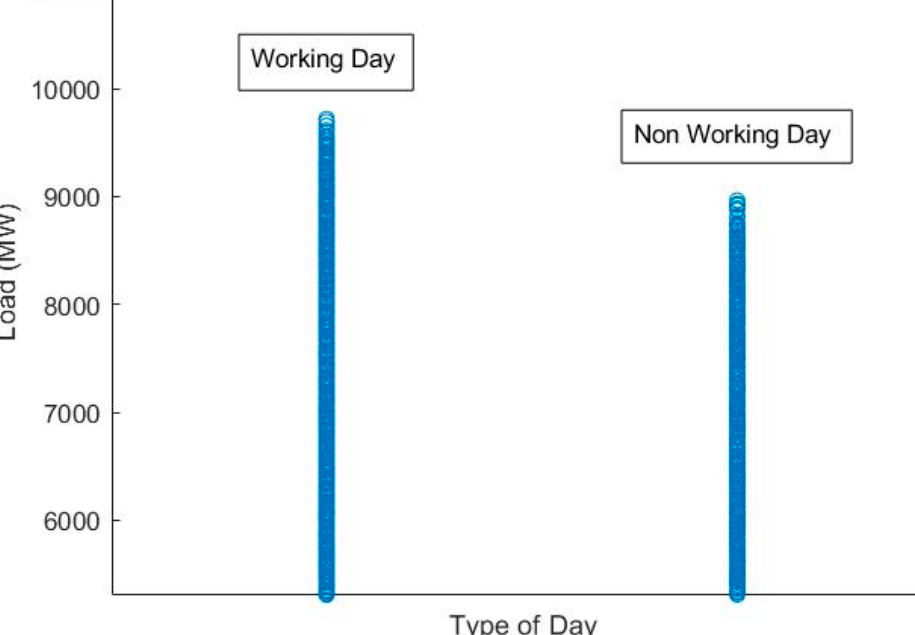
Figure 2. Energy consumption based on day type.